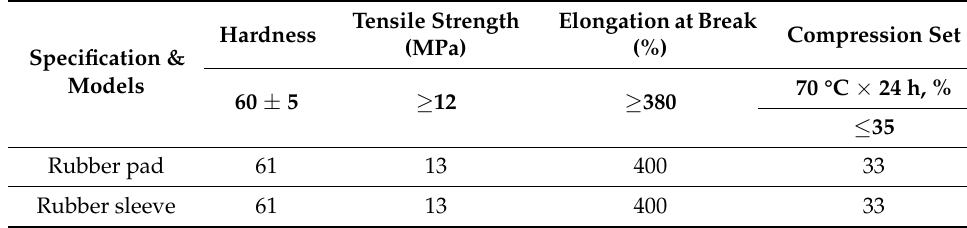
Table 2. Rubber properties in the semi-fixed dowel joints.